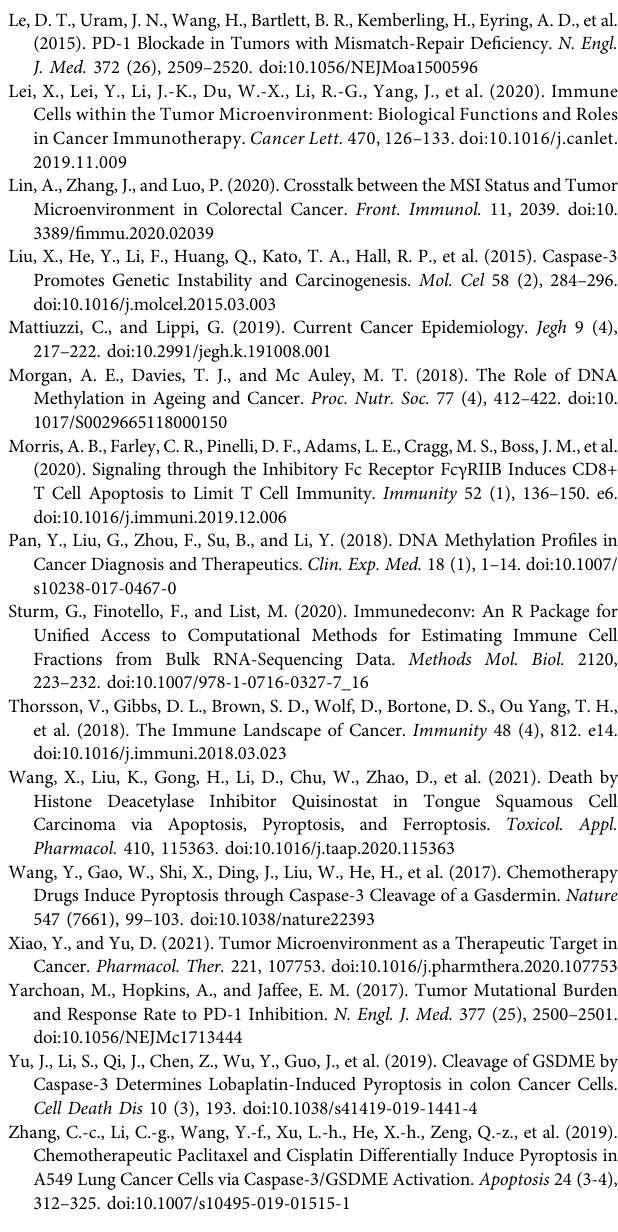
Supplementary Figure S3 | Relationship between CASP3 levels and the in fi ltration of other cancer-associated fi broblasts based on three algorithms. Supplementary Figure S4 | Based on the TIMER algorithm, the expression of CASP3 is related to the in fi ltration of immune cells in other tumours. Supplementary Figure S5 | Expression of CASP3 in the remaining tumours was based on the results of GO enrichment analysis. Supplementary Figure S6 | Expression of CASP3 is related to clinically relevant traits such as age and gender of HNSC and